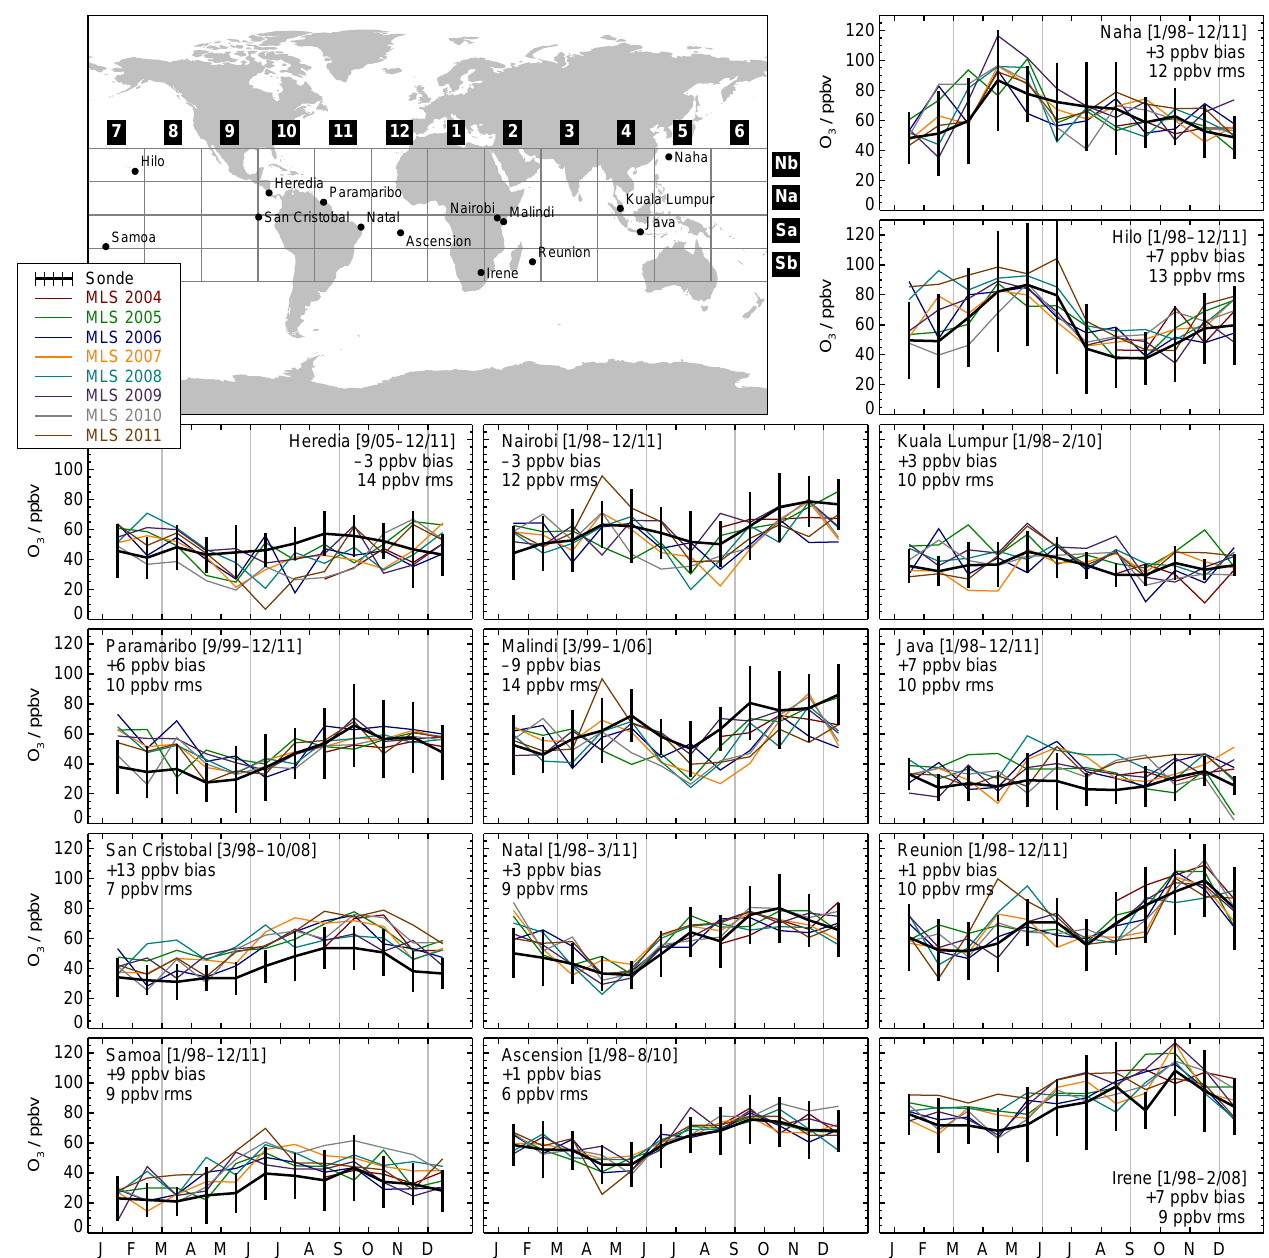
Fig. 5. Monthly average MLS O 3 observations (colored lines) at 215hPa over selected sonde stations (within ± 2.5 ◦ latitude, ± 5.0 ◦ longitude, giving 40–100 MLS observations over each station per month and hence 2–3ppbv precision for each monthly regional mean) compared to multi-year monthly 200hPa climatologies from each sonde station (black lines with error bars indicating standard deviation of the sonde observations). The bias and RMS difference between MLS and the sonde data are shown in each plot, along with the range of dates covered by each sonde record. Locations of the sonde stations are shown in the map at the top left, with the grid of the other figures overlaid for